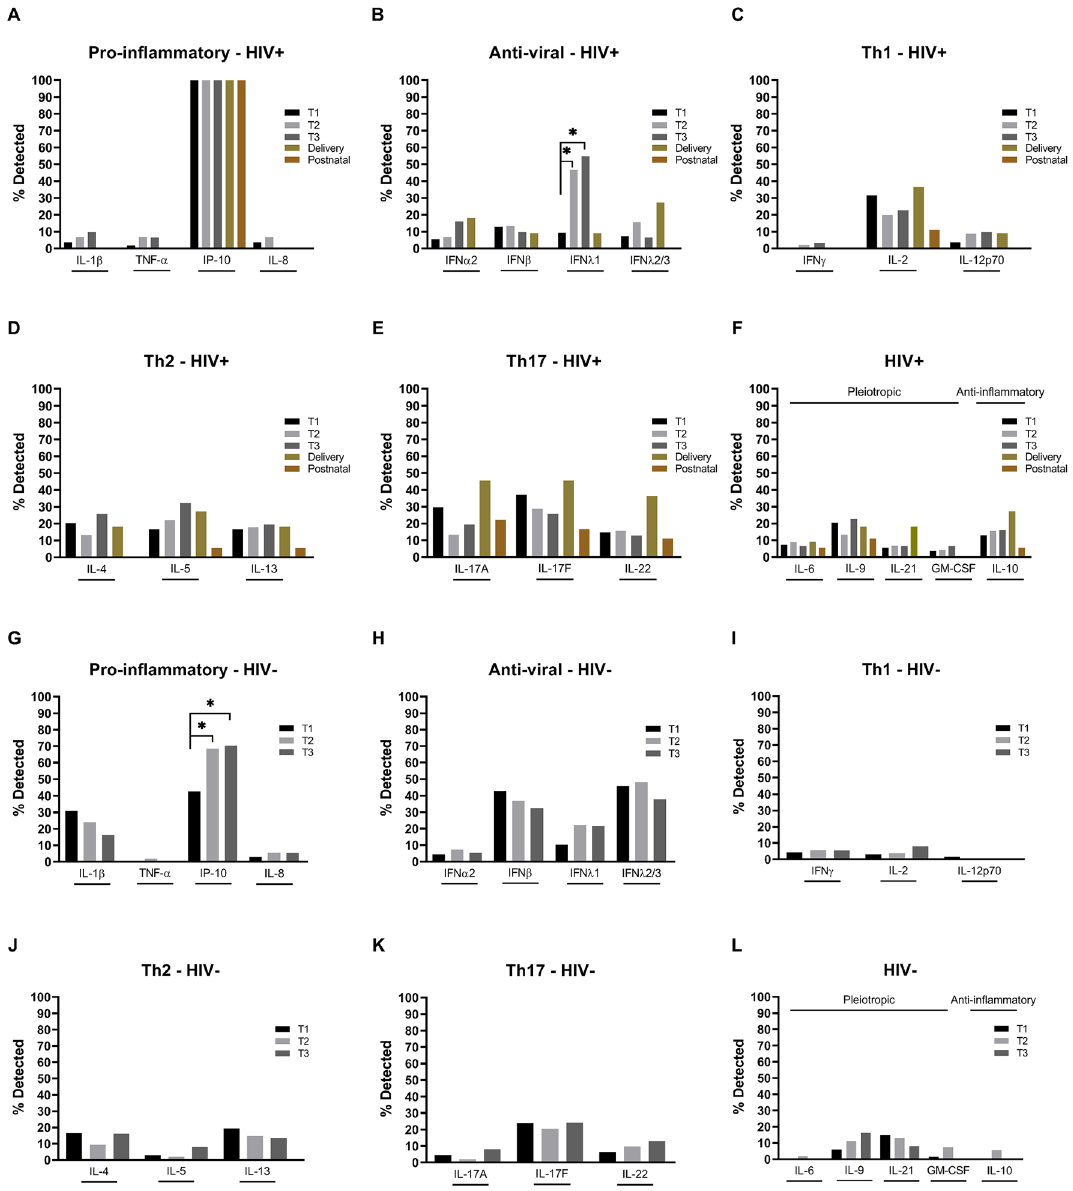
(IFNγ, IL-2, IL-12p70), ( D , J ) Th2 (IL-4, IL-5, IL-13), ( E , K ) Th17 (IL-17A, IL-17F, IL-21, IL-22) and ( F , L ) pleiotropic and anti-inflammatory (IL-6, IL-9, GM-CSF and IL-10 respectively) cytokines were measured in the maternal plasma collected during the first (T1), second (T2) and third (T3) trimester in women living with HIV (HIV+) ( A – F ) and HIV-negative women (HIV−) ( G – L ). Data are presented as the percentage of samples in which cytokines were detected by multiplex cytokine assay. *P <